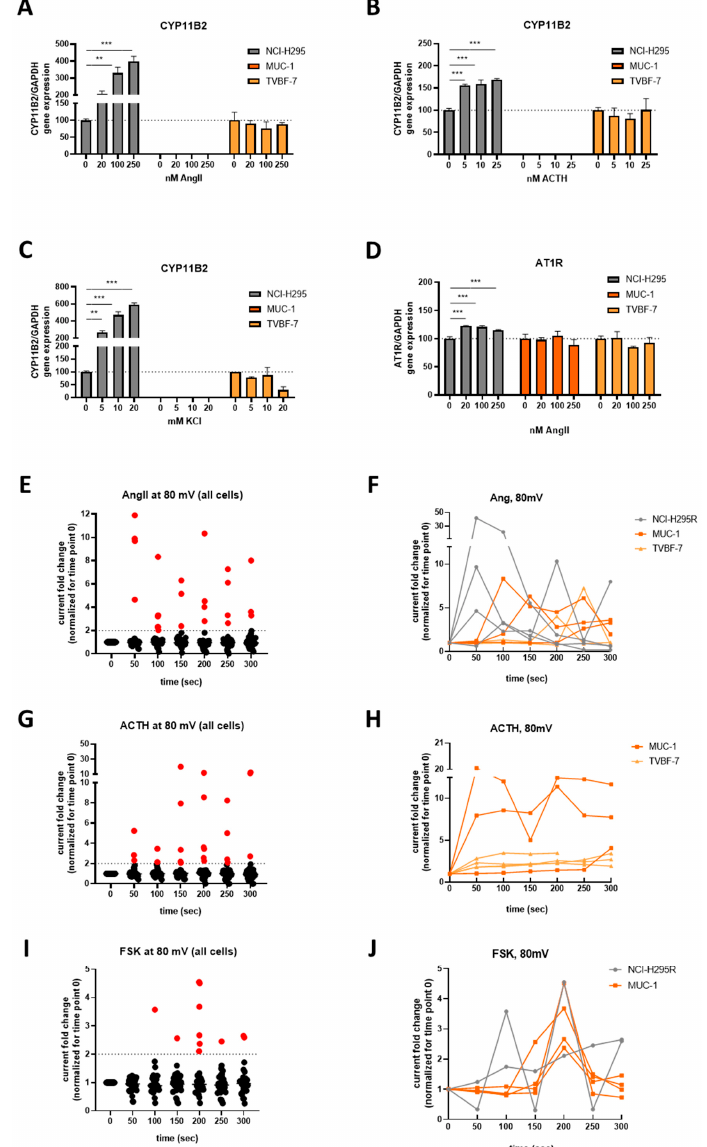
Figure 4. Activation of the mineralocorticoid pathway upon different stimulations. CYP11B2